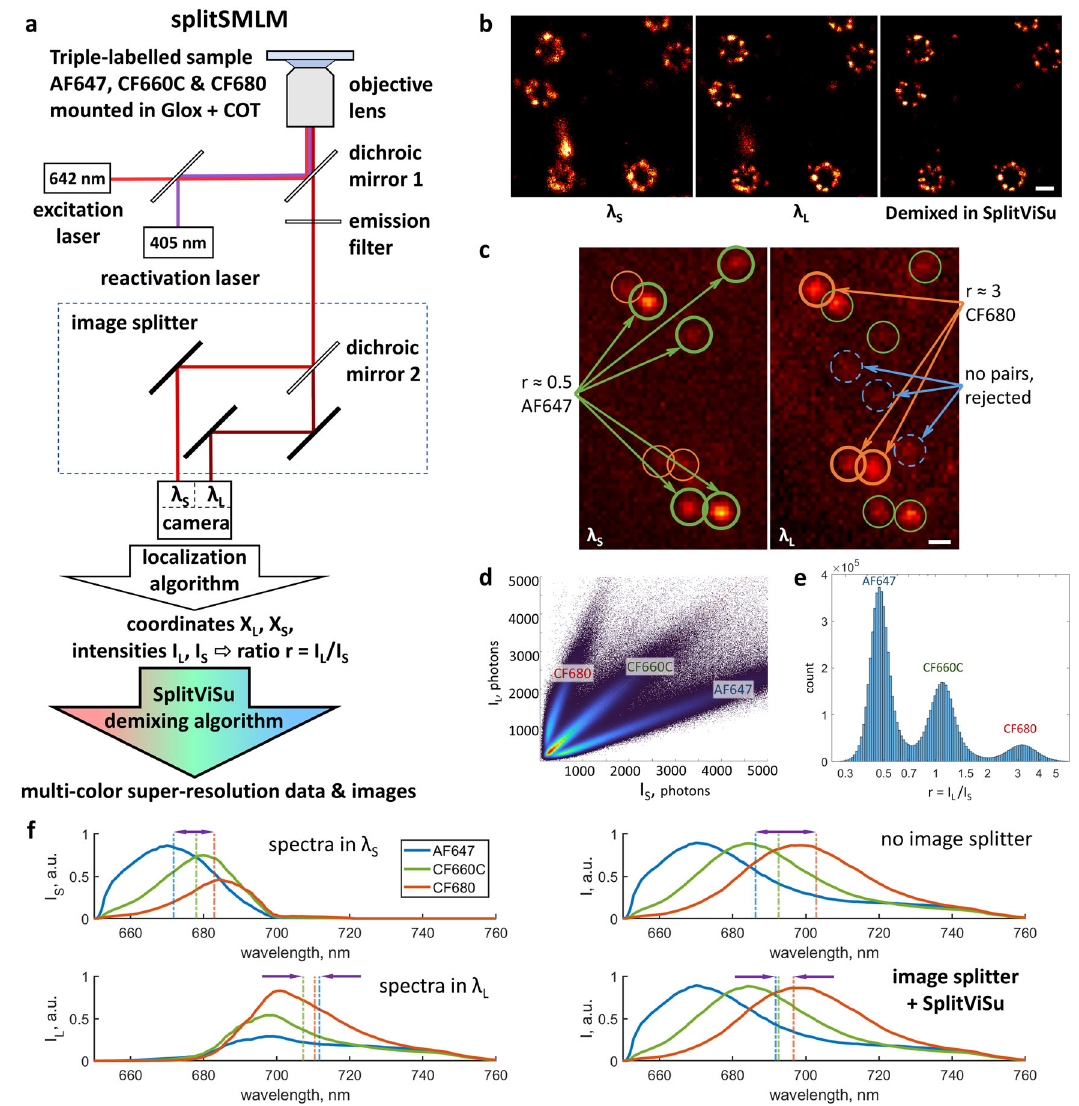
Fig. 1 Principle of splitSMLM. a Scheme of the splitSMLM imaging system and the overall work fl ow. b Super-resolution images of a single-labeled sample, reconstructed (from left to right) from localizations within the λ S channel, from localizations within the λ L channel or after demixing in SplitViSu, demonstrating removal of spurious localizations and resolution improvement. c Image of the two spectrally different channels, λ S and λ L (left and right, respectively), with localizations originating either from AF647 (green), CF680 (orange) or from background noise (blue). d Bivariate histogram of photon counts I S and I L originating from the λ S and λ L channels with three sectors corresponding to three fl uorophore species. e Univariate histogram of ratios r on a semi-log plot with three peaks corresponding to three fl uorophore species. f Fluorescence spectra of AF647, CF660C and CF680 calculated within the λ S and λ L channels (left), without image splitter (top right), or equivalent spectra after demixing in SplitViSu (bottom right). Vertical lines represent average wavelengths for the corresponding fl uorophores in the corresponding channels. Average wavelengths after demixing in SplitViSu are calculated as the mean values of the average wavelengths of the fl uorophores in the λ S and λ L channels. Arrows indicate maximum spectral difference within the triplet of fl uorophores and re fl ect the amount of chromatic aberrations in the corresponding setting. Scale bars, 100 nm ( b ) and 500 nm ( c